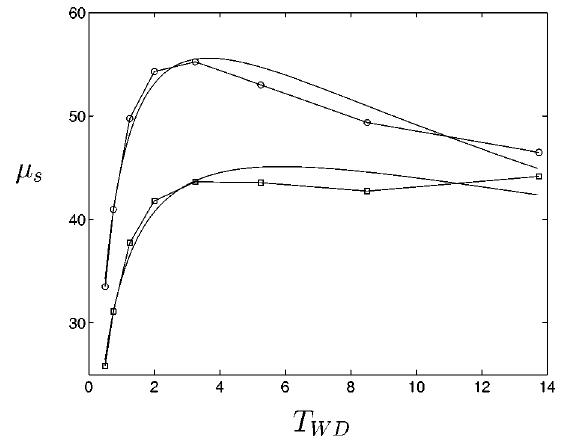
Fig. 6. Average lacunarity vectors for samples from the normal ( (cid:14) ) and tumour ( 2 ) class, using the (cid:22) s ( T WD ) lacunarity obtained by the 1D polygonization method. The lacunarity vectors were fitted in the log–log domain in a least-square sense by second order polynomials and the inverse of these curves are also plotted (solid lines). The lacunarity vectors were extracted from the second 10% peripheral segment of the cell